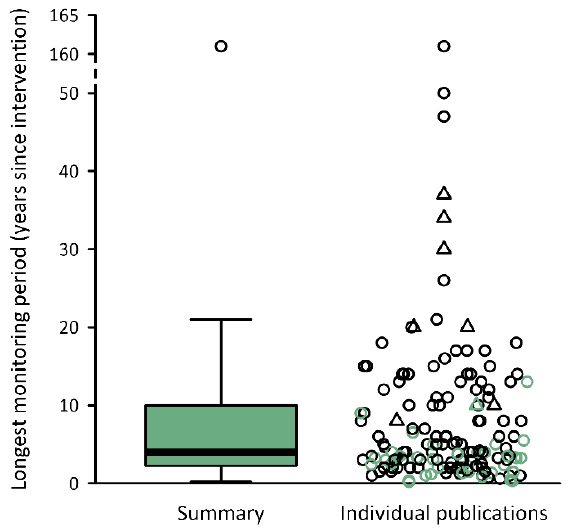
Figure 4. Longest time for which the effects